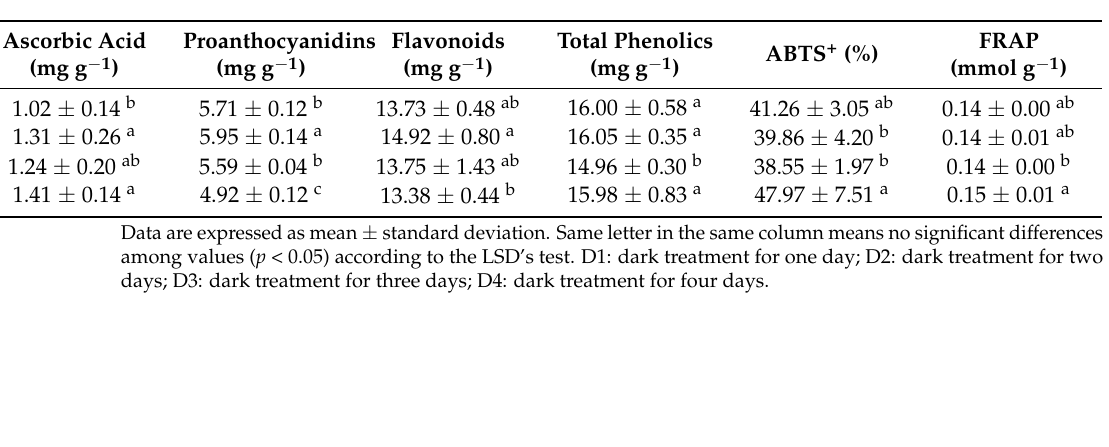
Table 3. Ascorbic acid, proanthocyanidins, flavonoids, total phenolics, and antioxidant activity content in different days of dark treatment of mustard